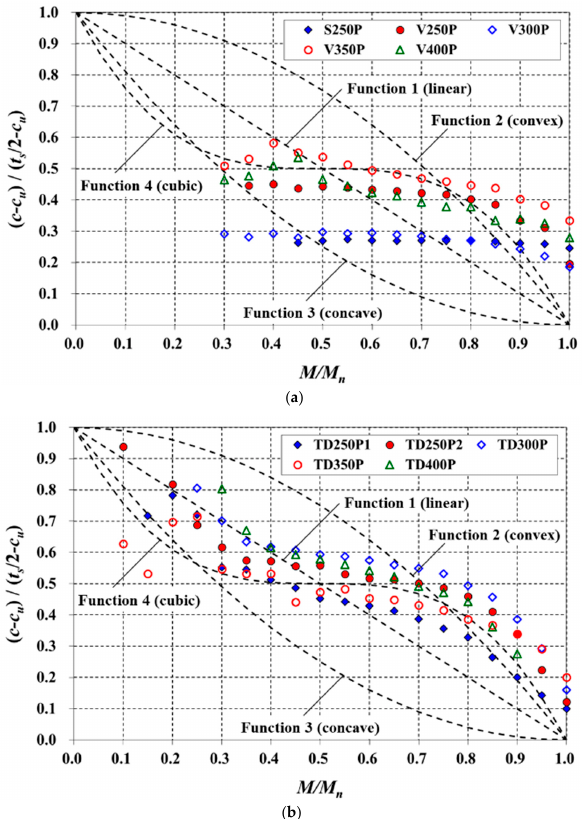
Figure 13. Variations of the neutral axis depth with M / M n : ( a ) S and V slabs; ( b ) TD slabs. The comparison results for the predicted immediate deflections are shown in Table 9. In the table, values with an error between δ exp and δ cal of less than 20% (0.8 ≤ δ exp / δ cal ≤ 1.2) For the TD specimens, where the influence of preloading was insignificant, the varia- are underlined. Although there were differences depending on the assumed variation tion of the neutral axis depth tended to be similar to Function 1 or Function 4. functions, the proposed procedure exhibited a large error and unstable prediction over the entire load level for the S and V slabs. They were very lightly reinforced slabs, and the values of c upon reaching M n were significantly different from those expected [9]. As the S and V slabs had a fairly low ρ , they were out of the main area of interest during the derivation of Equation (13), which would also increase the errors. Moreover, owing to causes such as initial cracks, the neutral axis depth demonstrated only a small difference compared with M / M n , as shown in Figure 13a. These factors would have resulted in less effective predictions for the S and V slabs. This procedure was mainly derived for the TD slabs with a general range of ρ , and thus, much better predictions were achieved for TD slabs compared with S and V slabs. TD250P3 and TD250P4, which were designed with a very high ρ , were not of primary concern, and as can be expected, their predictions were quite conservative. Table 9. Comparison of immediate deflection ( δ exp / δ cal ). Function Specimen